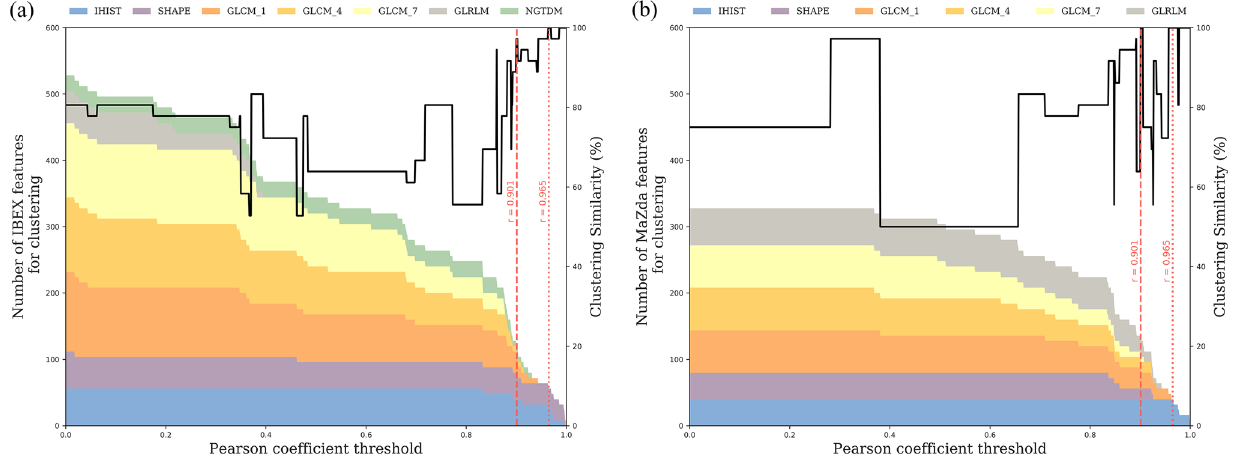
Figure 4. Comparison of hierarchical clustering of patients with PyRadiomics and IBEX using ( a ) all shared features and ( b ) a sub-set of reproducible features ( r > 0.901 ). Unsupervised hierarchical clustering generates a (left) radiomic signature of change in apparent diffusion coefficient (ADC) features after one fraction of radiotherapy in 36 head and neck cancer patients and (right) the resulting patient groups. Clustering with ( a ) non-reproducible features creates a difference in the patient groups generated from PyRadiomics or IBEX features. Clustering with ( b ) a sub-set of reproducible features leads to almost identical patient groups generated from PyRadiomics or IBEX features.